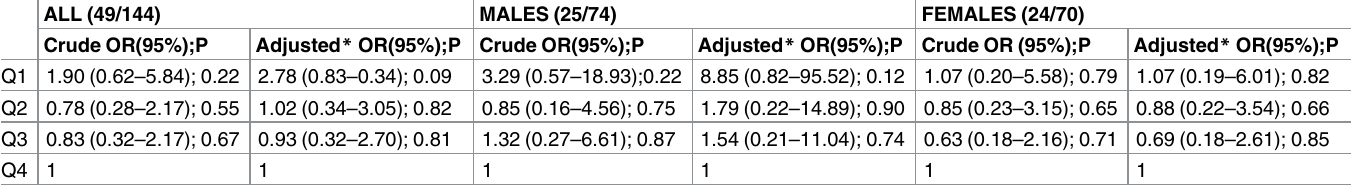
Table 3. Risk of stroke in relation to the highest quartile of IgM anti-OxPS. Associationbetweenlevels of IgM anti-OxPS and risk for stroke, (as com- pared to 622 controls) among all participants and men and women separately. In tables, the highestquartile, Q4, is set as 1. Both cases and controls were includedas the basis for division into quartiles.